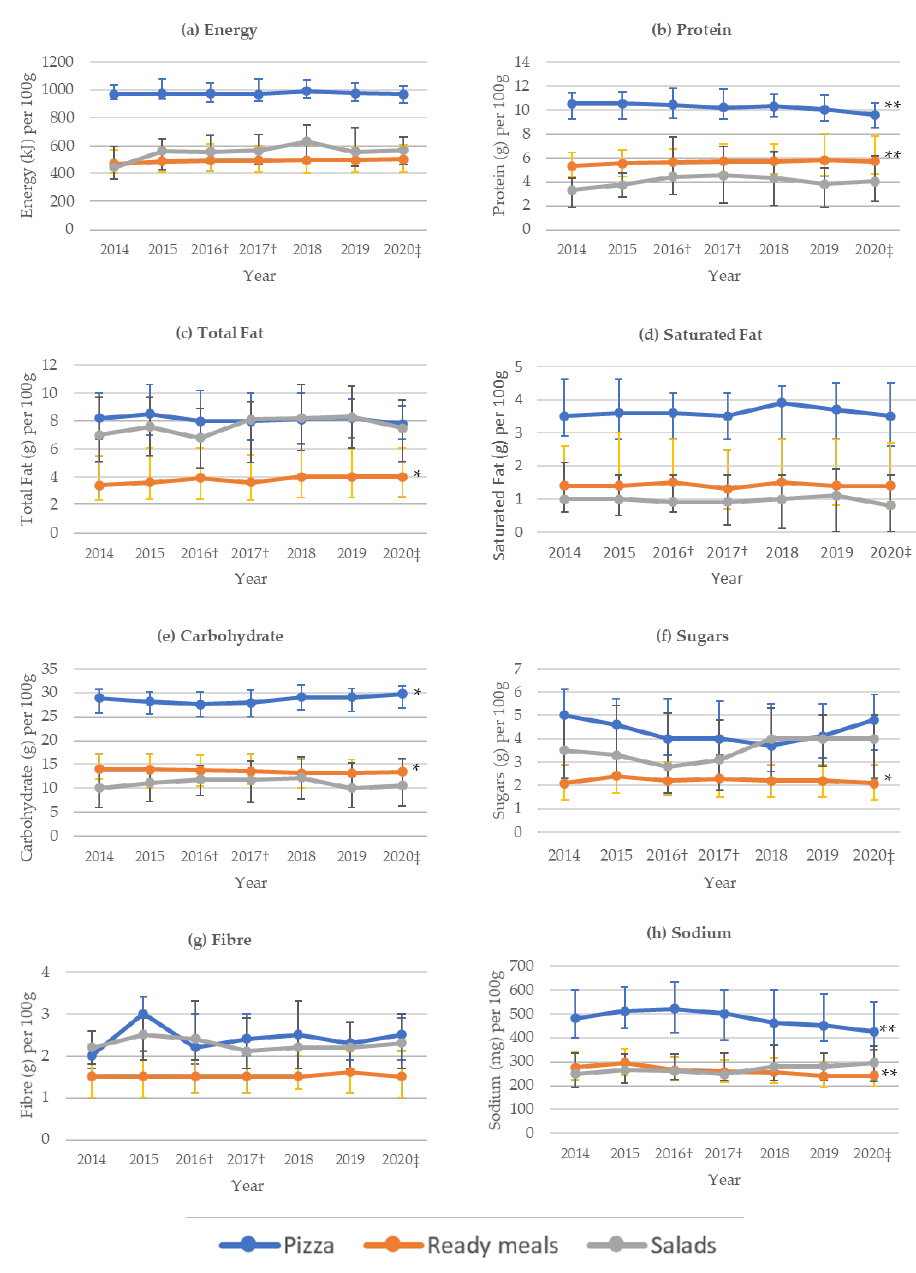
Figure 1. Nutrient content per 100 g for ready meals, pizzas and salads from 2014 to 2020 (median and interquartile range). ( a ) Energy (kJ); ( b ) Protein (g); ( c ) Total Fat (g); ( d ) Saturated Fat (g); ( e ) Carbohydrate (g); ( f ) Sugars (g); ( g ) Fibre ( g , h ) Sodium (mg). Data for 2014 to 2019 from FoodTrack™ database; † ALDI products introduced in 2016 and IGA products introduced in 2017; ‡ data for 2020 from Woolworths, Coles and ALDI in Adelaide; * p -trend < 0.05; ** p -trend < 0.001; §fibre values were available for 1467 (57%) ready meals, 152 (26%) pizzas and 503 (83%) salads.